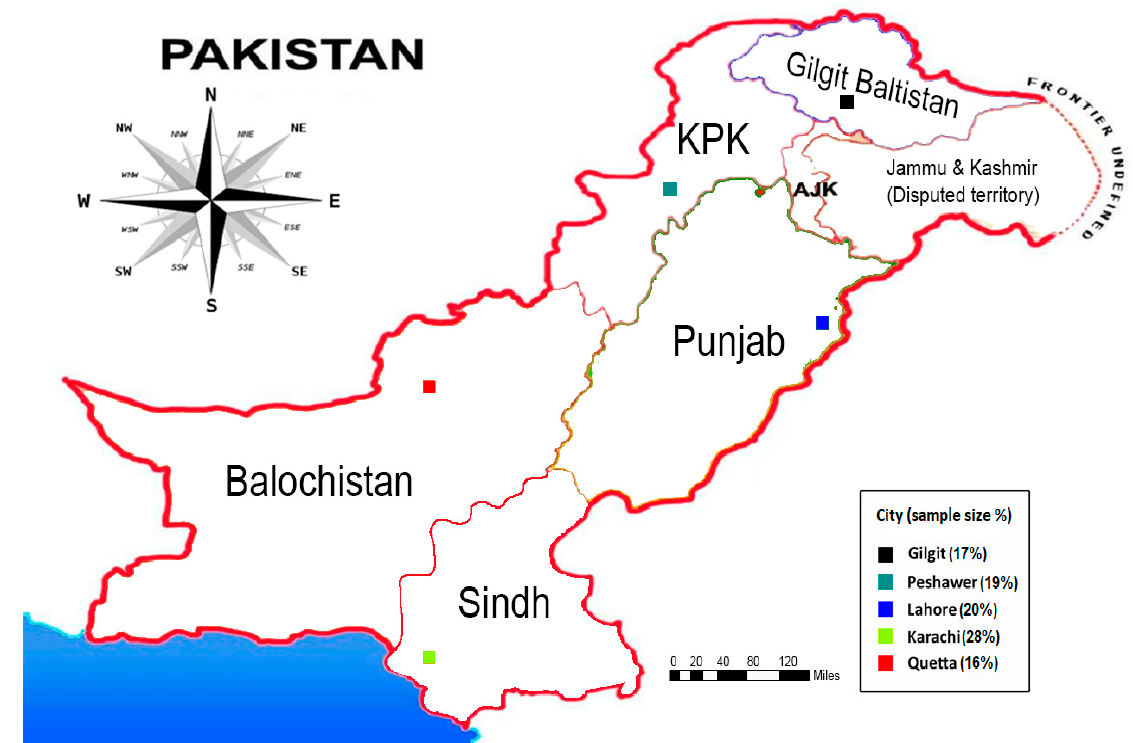
Figure 3. Survey sites.